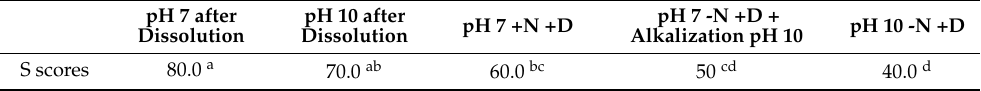
Table 3. S scores given by the twenty panel members for the five assessed